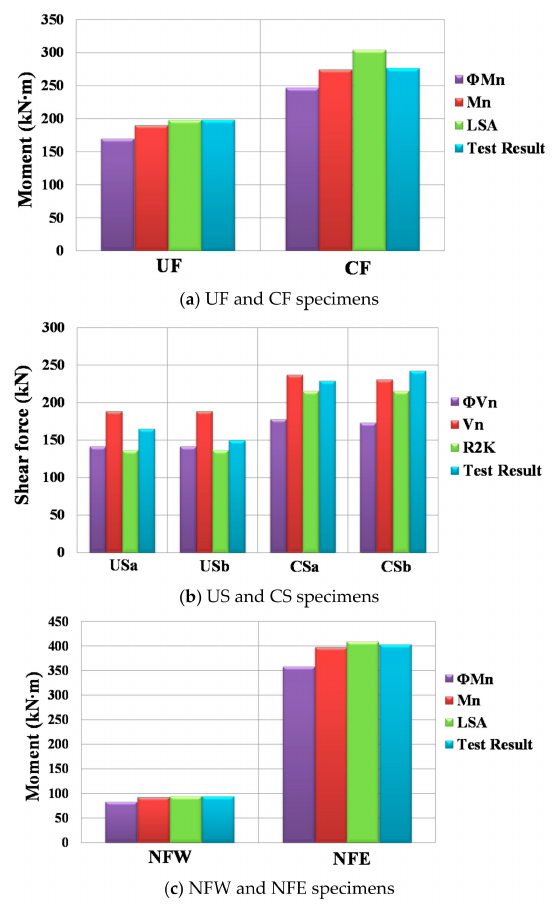
Figure 15. Strength evaluation